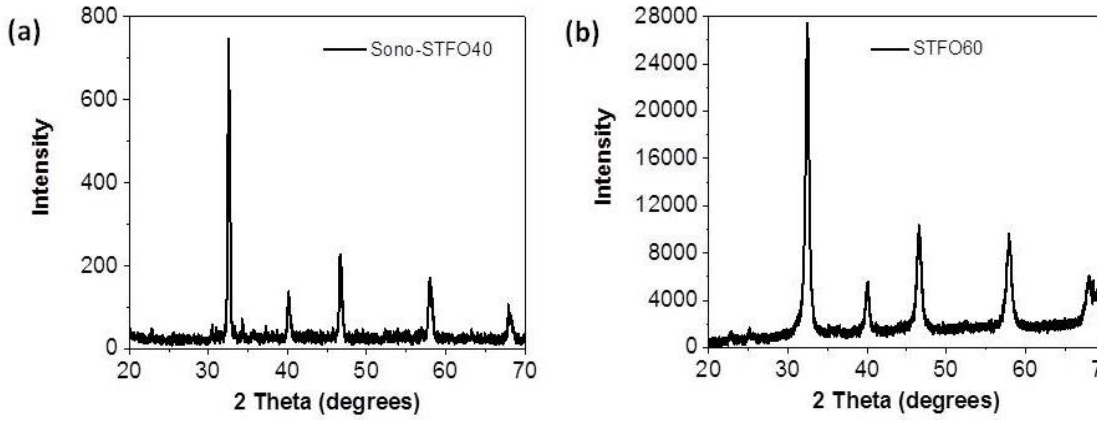
Figure 3. X-ray diffractogram of ( a ) the Sono-STFO40 and ( b ) commercially available STFO60.